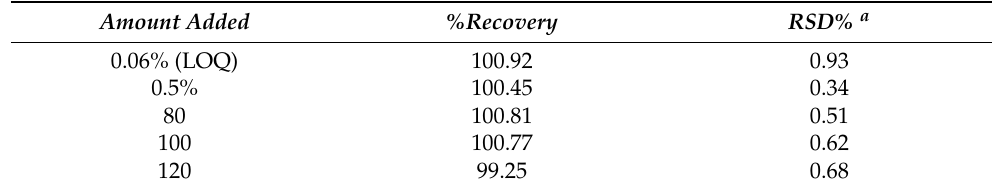
Table 3. Accuracy results.